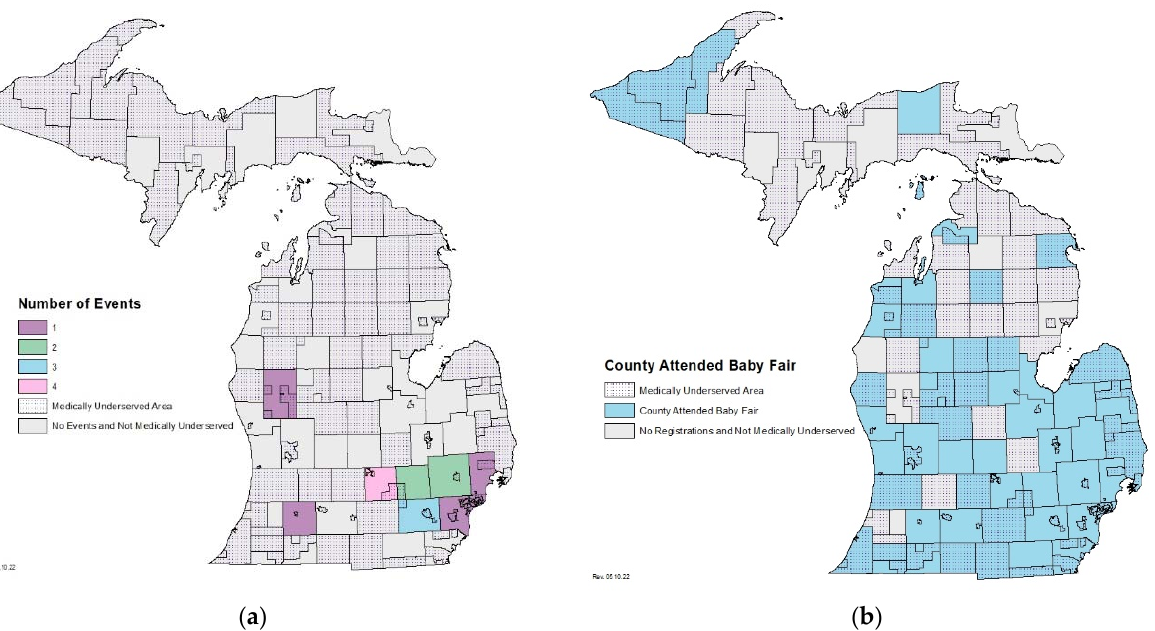
Figure 1. Geographic reach of the NBS program educational efforts: ( a ) Counties where the Michi ‐ gan NBS Program was in attendance as a vendor at an in ‐ person educational event. ( b ) Counties in attendance at the Michigan Virtual Baby Fairs from